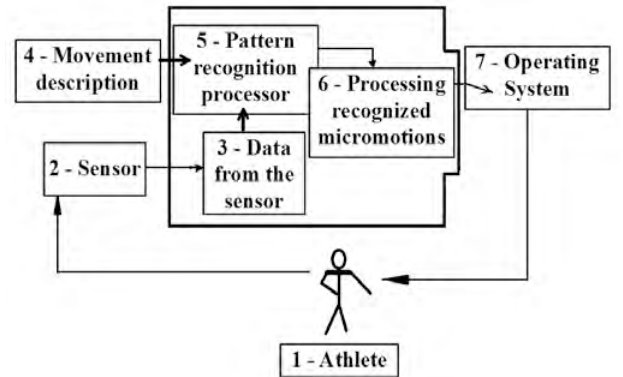
Fig.1. Block diagram of СЕА16 model for registration micro movements by XYZ